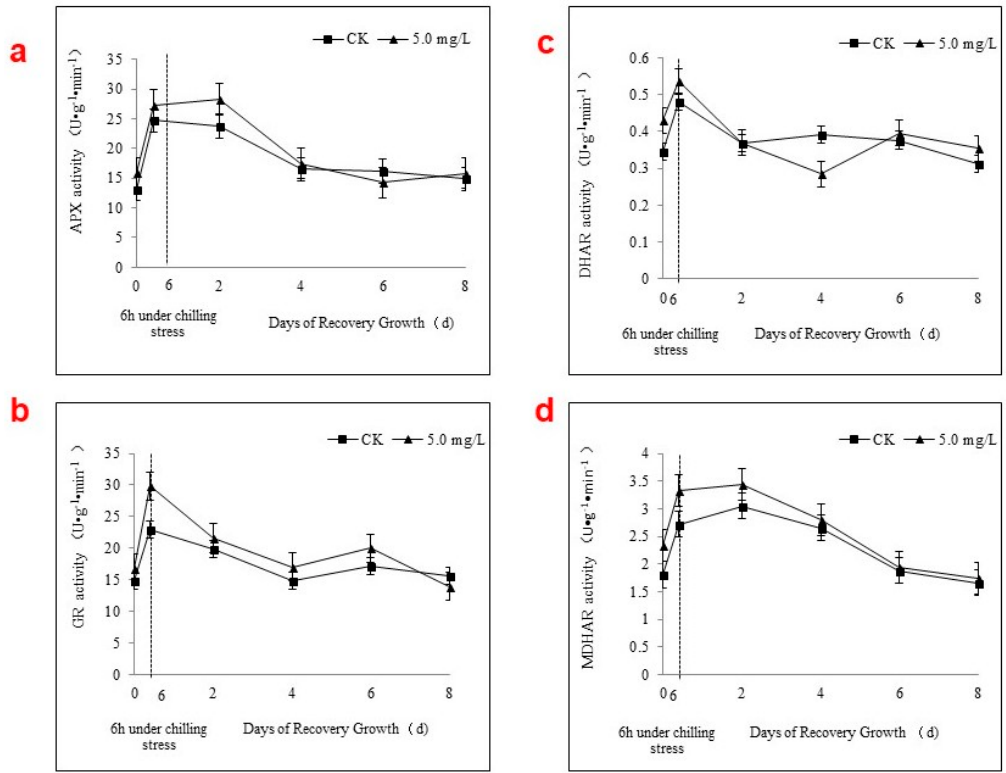
Figure 4. Effects of foliar spraying an Se solution (5 mg·L − 1 ) on the activity levels of AsA-GSH cycle-related enzymes APX ( a ), GR ( b ), DHAR ( c ), and MDHAR ( d ) in Akihime strawberry leaves during chilling stress and recovery growth.